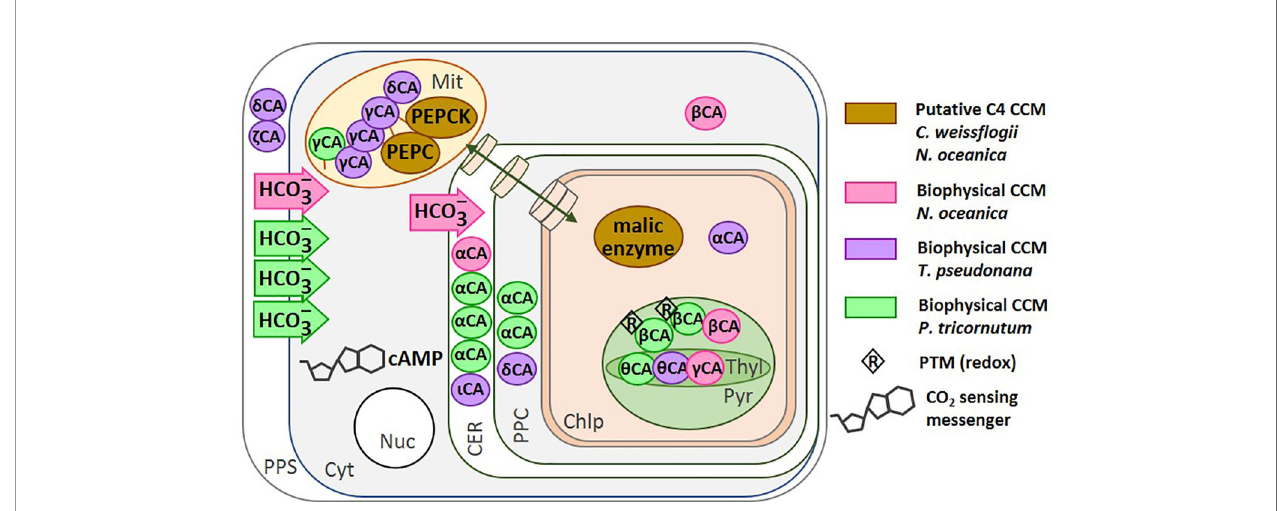
FIGURE 3 | Location of the CCM components in different diatom species. The carbonic anhydrases (circles) and bicarbonate transporters (arrows) are shown for: N. oceanica (Wei et al., 2019) (magenta), T. pseudonana (Samukawa et al., 2014; Jensen et al., 2020) (purple), and P. tricornutum (Jensen et al., 2020) (green). The putative C4-CCM components proposed for N. oceanica (Wei et al., 2019) and C. weiss fl ogii (Reinfelder et al., 2000; Ohno et al., 2012; Hopkinson et al., 2016; Tanaka et al., 2016). The transport of molecules between the cytoplasm and the chloroplast is represented by a green double-headed arrow across cylinders. Redox regulation of CA activity has been shown on the isolated P. tricornutum b -CA in vitro . PEPC, Phosphoenolpyruvate Carboxylase; PEPCK, Phosphoenolpyruvate Carboxykinase; CA, Carbonic Anhydrase; PPS, Periplasmic Space; CER, Chloroplast Endoplasmic Reticulum; PPC, Periplastidial Compartment; Mit, Mitochondrion; Chlp, Chloroplast; Cyt, Cytoplasm; Nuc, Nucleus. Figure adapted from Jensen et al.